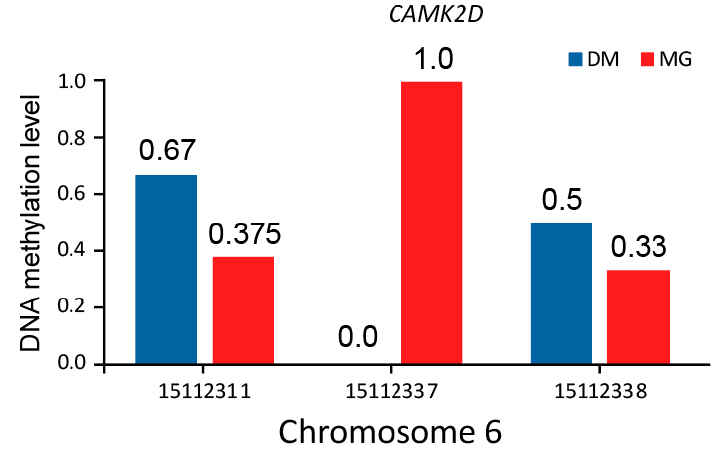
Figure 7. DNA methylation level of differentially methylated sites within CAMK2D, all the methylated cytosine were covered more than three times.